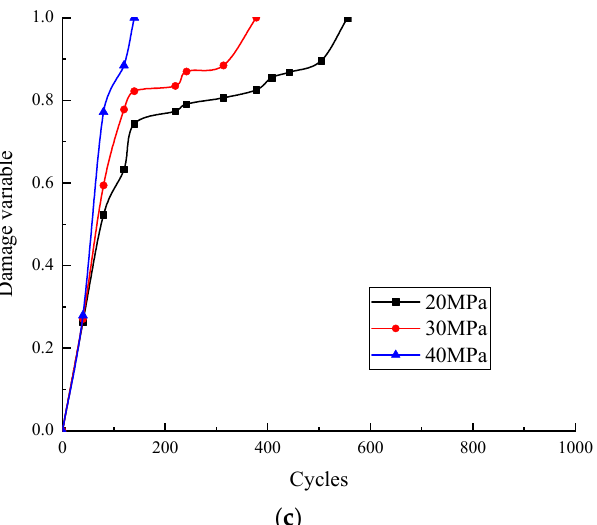
Figure 17. Relationship between the number of disturbance cycles and the damage variable: ( a ) 60%; ( b ) 70%; ( c ) 80%.